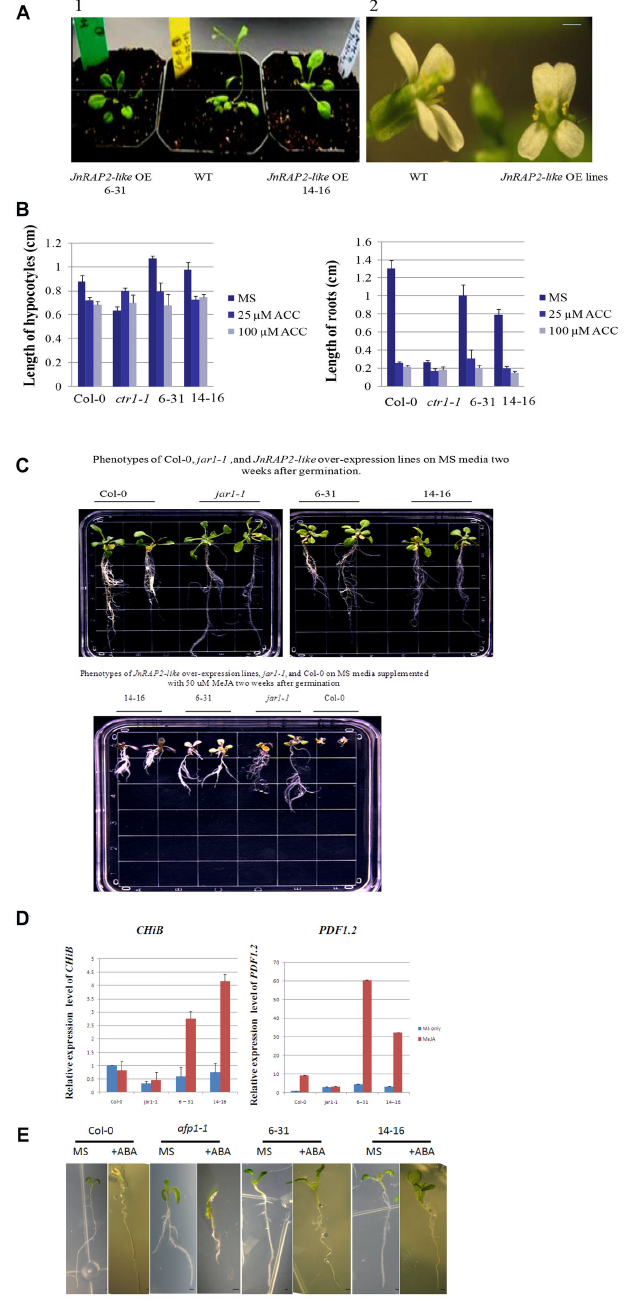
Figure 6. Responses of JnRAP2-like over-expression (OE) lines to hormone treatment. A . (1) Phenotypes of wild-type and JnRAP2-like OE plants. (2) Morphology of wild-type plant flowers (left) and JnRAP2-like OE plant flowers (right). B . Lengths of hypocotyls and roots of wild-type and JnRAP2-like OE plants. ctr1-1 was used as a ethylene-response reference. C . Phenotype of two representative lines overexpressing JnRAP2-like in the wild type (Col-0) background compared to Col-0 and jar1-1 (JA- response mutant) plants. Top, all plants grown for two weeks on MS only; bottom, all plants grown for three weeks on MS containing 50 µM MeJA. D . Expression of defense-associated genes PDF1.2 and ChiB in JnRAP2-like OE lines and wild-type plants with and without 50 µM MeJA treatment two weeks after germination. Gene expression is presented relative to average treated wild-type levels. The average and SE of two biological replicates are presented. E . Phenotype of two representative lines overexpressing JnRAP2-like compared to Col-0 and afp1-1 , ABA-response marker plants. All plants were grown for one week on MS containing 0.1 µM ABA. Scale bar = 1 mm. doi: 10.1371/journal.pone.0075857.g006 PLOS ONE |